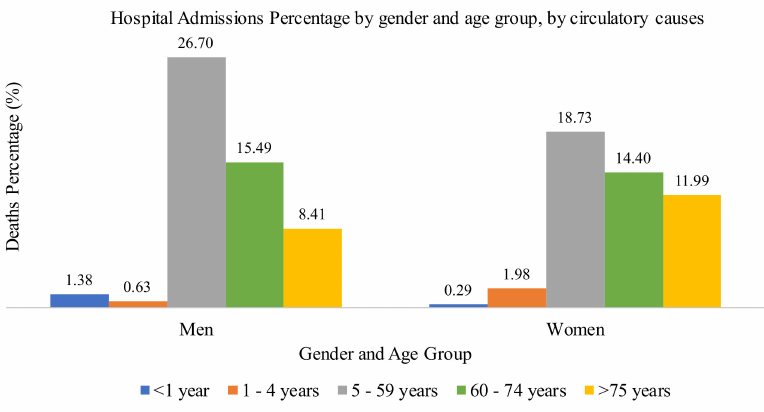
Figure 9. Hospital admission percentage by gender and age group for circulatory